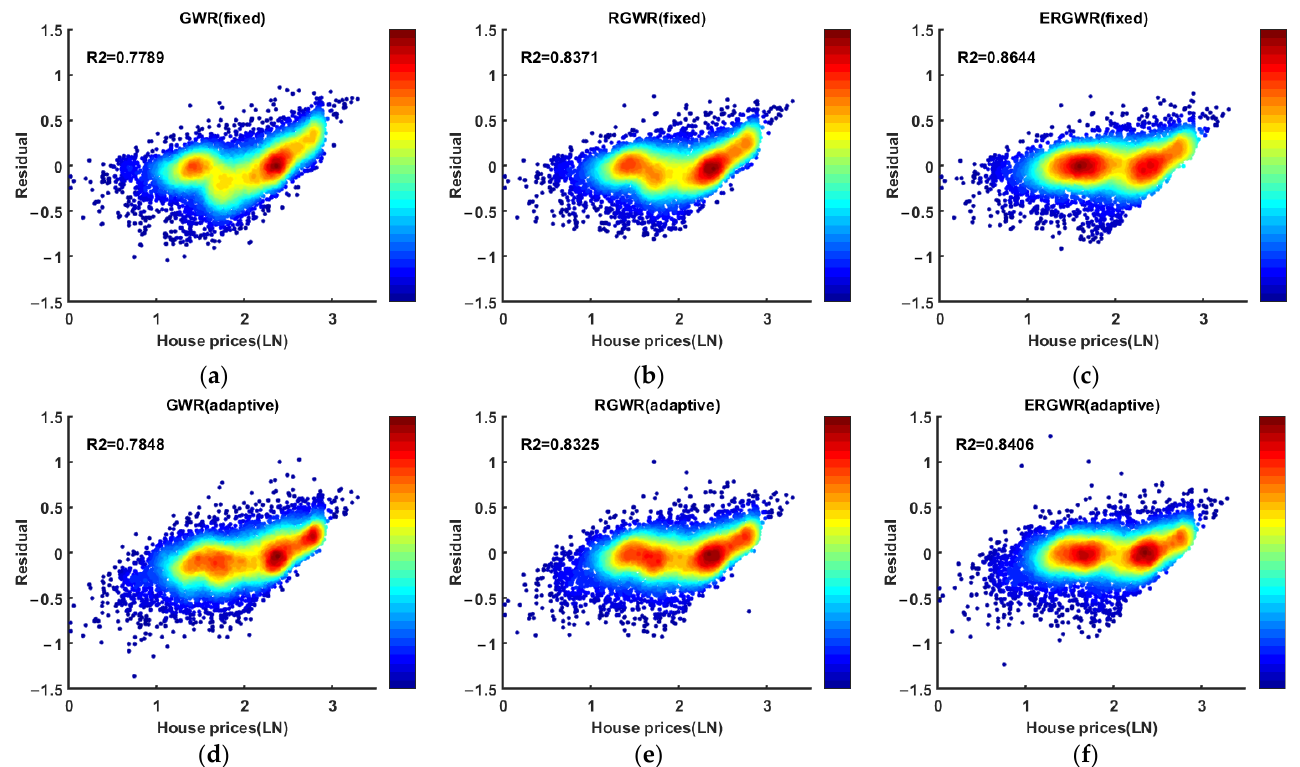
Figure 4. Fitting effect distribution of GWR, RGWR, and E-RGWR. ( a ) Predicted values and residuals of the housing prices and residual by the GWR model under the fixed bandwidth strategy; ( b ) predicted values of the housing prices and residuals by the RGWR model under the fixed bandwidth strategy; ( c ) predicted values of the housing prices and residuals by the E-RGWR model under the fixed bandwidth strategy; ( d ) predicted values of the housing prices and residuals by the GWR model under the adaptive bandwidth strategy; ( e ) predicted values of the housing prices and residuals in the RGWR model under the adaptive bandwidth strategies; ( f ) predicted values of the housing prices and residuals by the E-RGWR model under the adaptive bandwidth strategy.